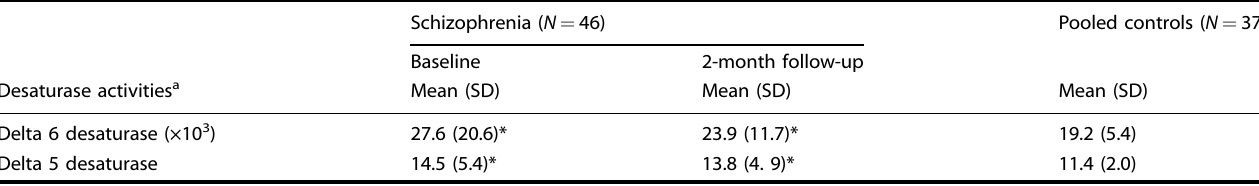
Table 3. Desaturase activities estimated from RBC in schizophrenia patients and